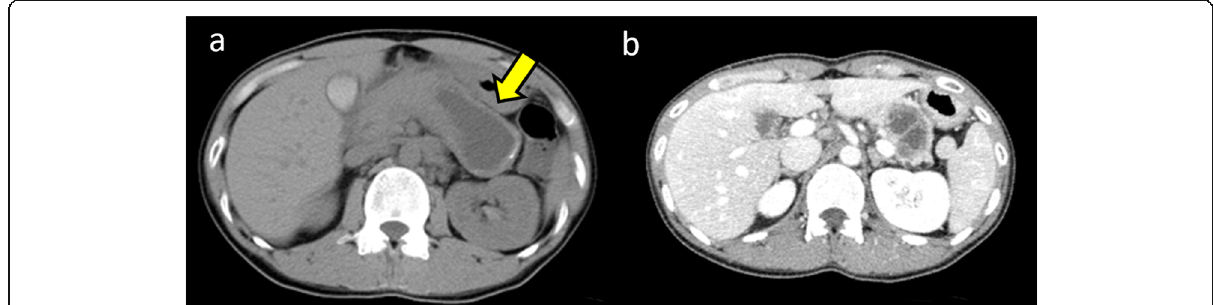
Fig. 1 Computed tomography (CT) at onset revealed the presence of a cystic tumor measuring 60 mm in diameter in the pancreatic tail ( a , arrow). Enhanced CT in our department also revealed a tumor in the pancreatic tail with an internal septal formation ( b ). There was no evidence of a nodular lesion in the tumor or ascites.